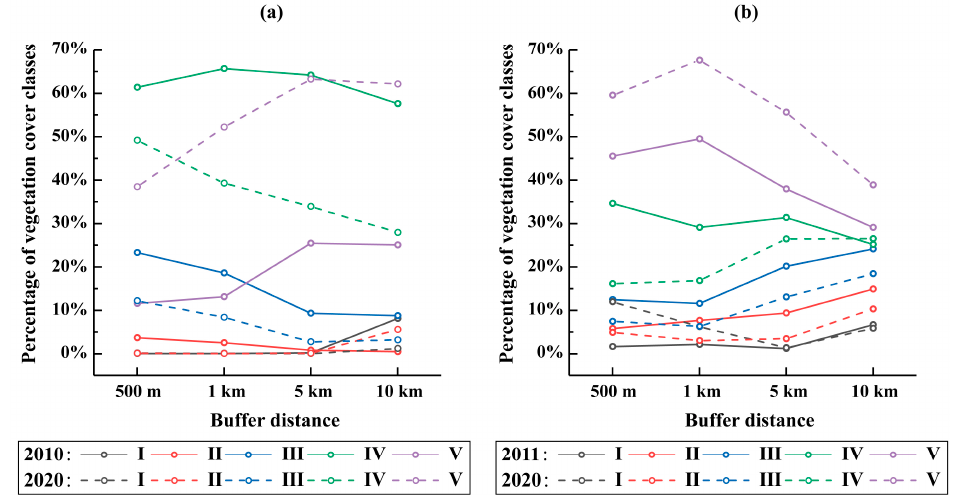
Figure 5. Changes in the area percentage of different vegetation cover classes in different buffer zones ( a ) for Sino Iron and ( b ) for Taldybulak Levoberezhny.